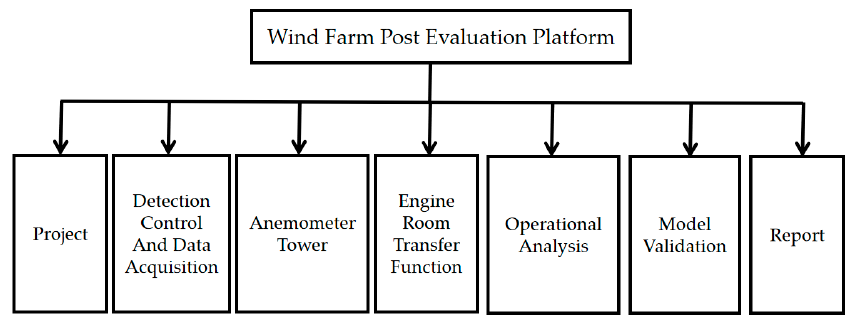
Figure 1. Function Module